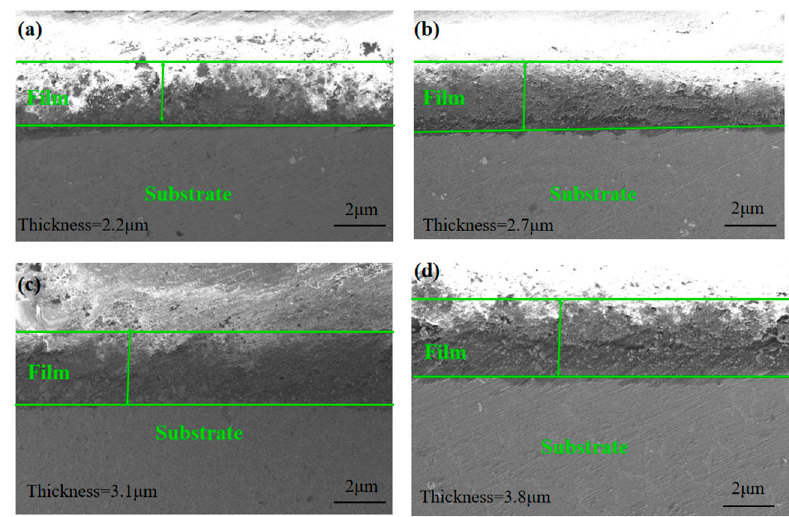
Figure 4. Cross-sectional SEM micrographs of ( a ) 600; ( b ) 1200; ( c ) 2000; ( d ) 5000 .